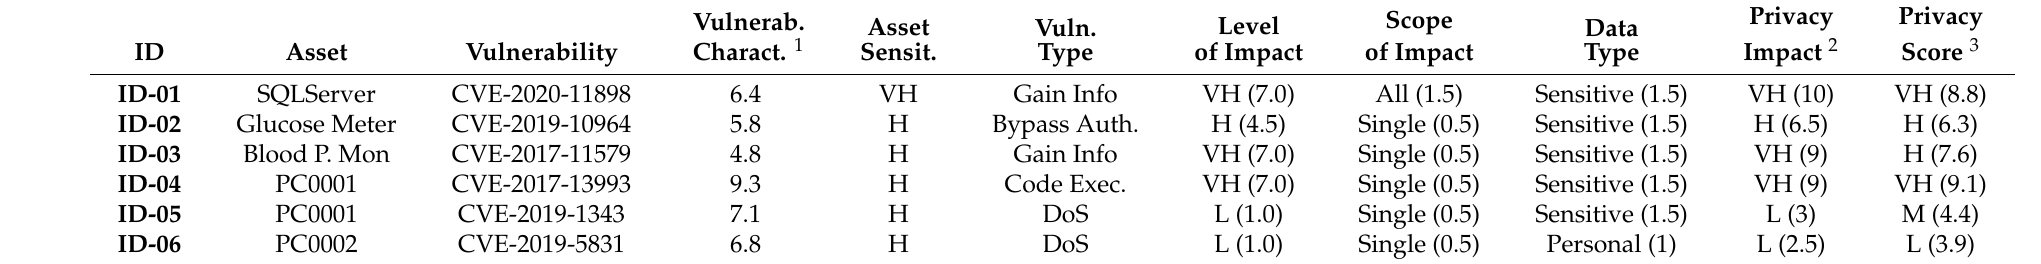
Table 6. Use case threats, assets and privacy scores